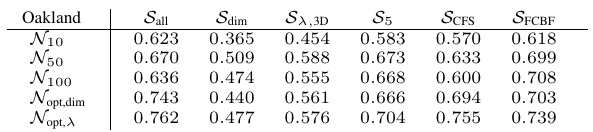
Table 7: Mean class recall values for QDA-based classifica- tion using different neighborhood definitions and different feature